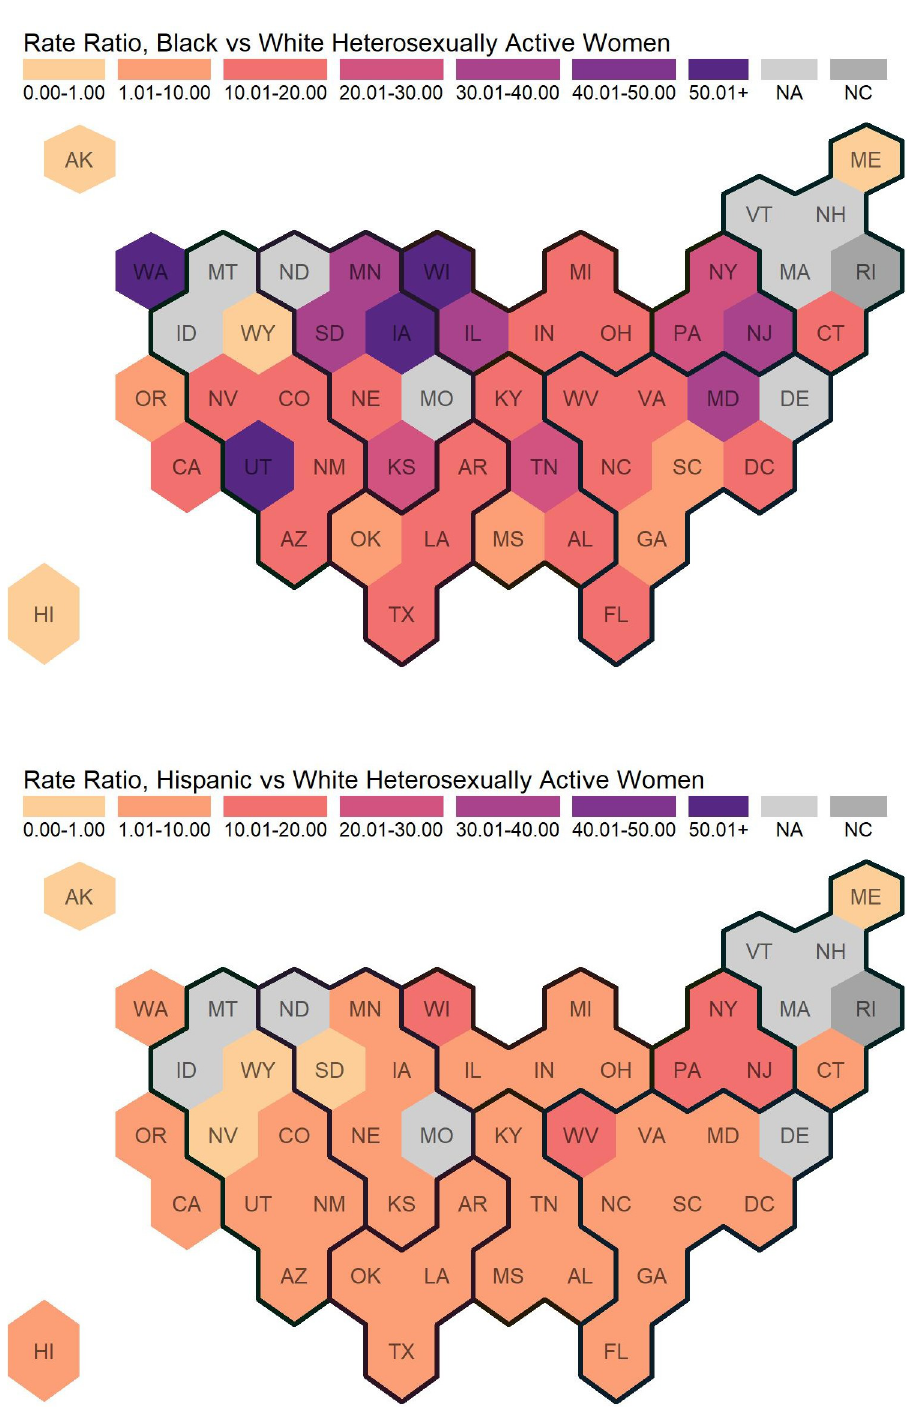
Fig 5. Rate ratios of newly diagnosed HIV cases among heterosexually active Women Ages 18+. Regions are indicated with the dark black lines. For most states in the lowest category with rate ratio between 0.00 and 1.00, there were no or very few new diagnoses among Black or Hispanic heterosexually active women. This commonly occurred in states with smaller populations. Eight states did not report stratified data (by sex, transmission category,, and race/ ethnicity), and are indicated with “not available” (NA). One state does not have calculated rate ratios because there were 0 new diagnoses among White heterosexually active women, and are indicated with “not calculated” (NC).